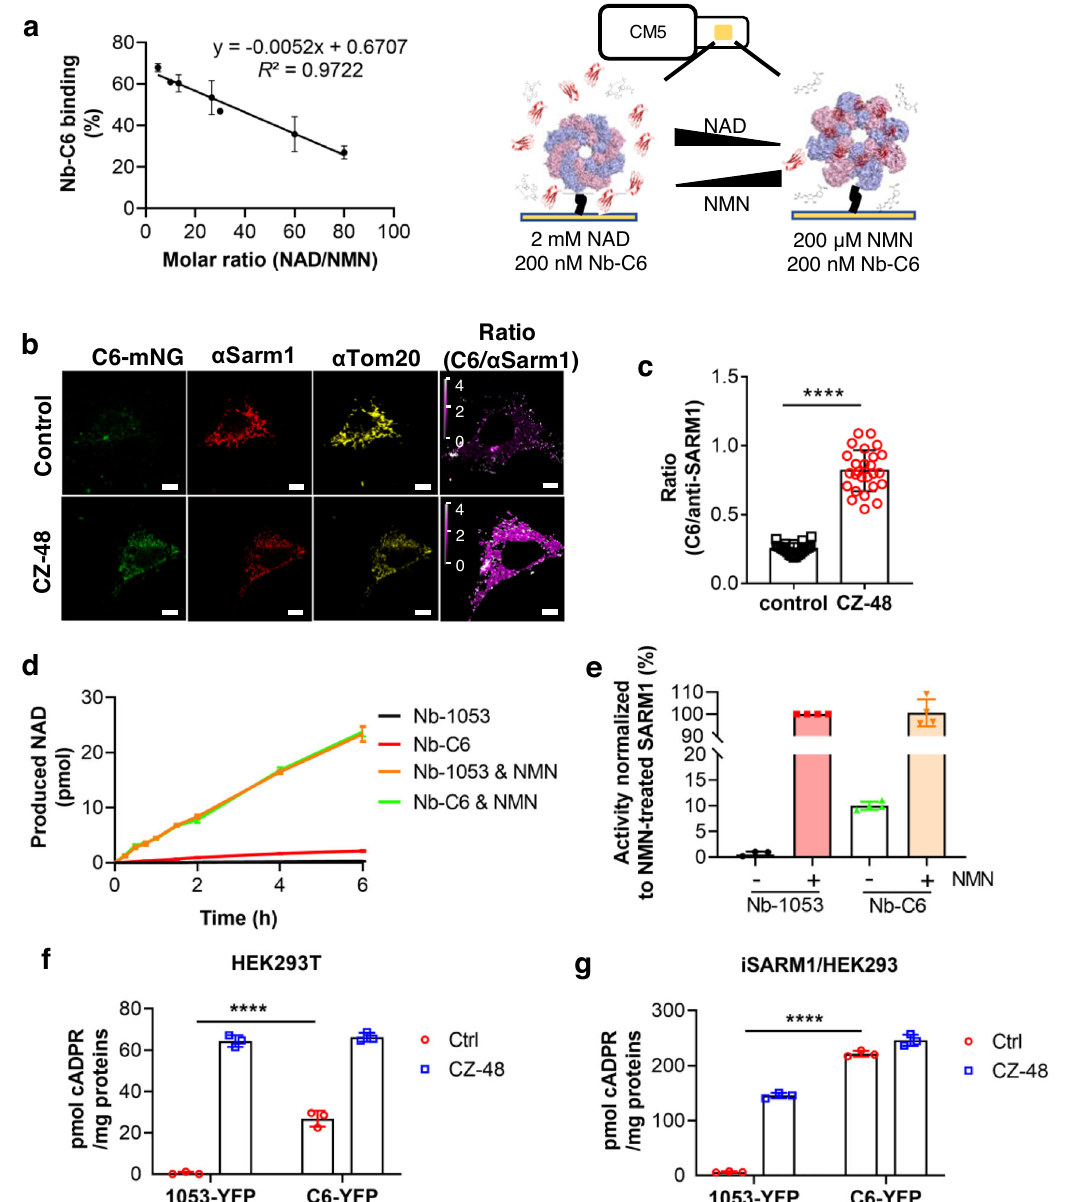
Fig. 2 | Nb-C6 indicates and facilitates SARM1 ’ s activation in vitro and in cells. a SPR analysis of Nb-C6 binding to the immobilized SARM1 when the mobilizing modulator switching from 2mM NAD to 200 μ M NMN. The Nb-C6 binding, cal- culated from RU value and normalized with that in the condition of 200 μ M NMN (set as 100%), and the molar ratio of NAD and NMN were fi t into a linear model. ( n =4biologicallyindependentexperiments,mean±SD) b Nb-C6stainstheCZ-48- activated SARM1. HEK293 cells carrying the inducible expression cassette for SARM1 were treated with 1 μ g/mL doxycycline for 12h and then 100 μ M CZ-48 for 6h.Thecellswere fi xedandstainedwithC6-mNeonGreen,anti-SARM1,anti-Tom20 asdescribedintheMethods.Horizontalscalebar:5 μ m;verticalscalebar:0-4,ratio of the signals from Nb-C6 staining and anti-SARM1 staining. c The ratio of Nb-C6 and anti-SARM1 signals was calculated and plotted. ( n =20 cells examined over 3 biologically independent samples, mean±SD, p <0.0001 one-way ANOVA test) d Nb-C6 could activate SARM1 in vitro, measured by reverse cycling assay. The